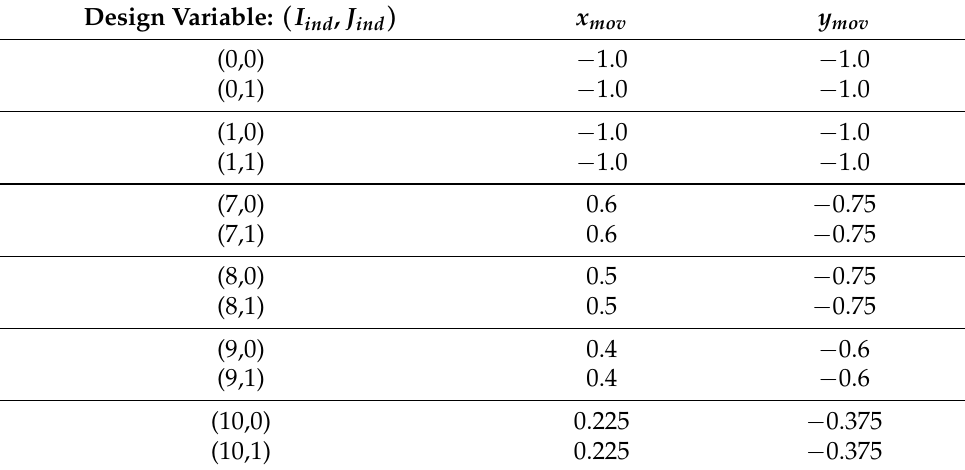
Table 4. Scale factors at each of the non-fixed FFD design variables for the NLR7301 SDO. Design Variable: ( I ind , J ind